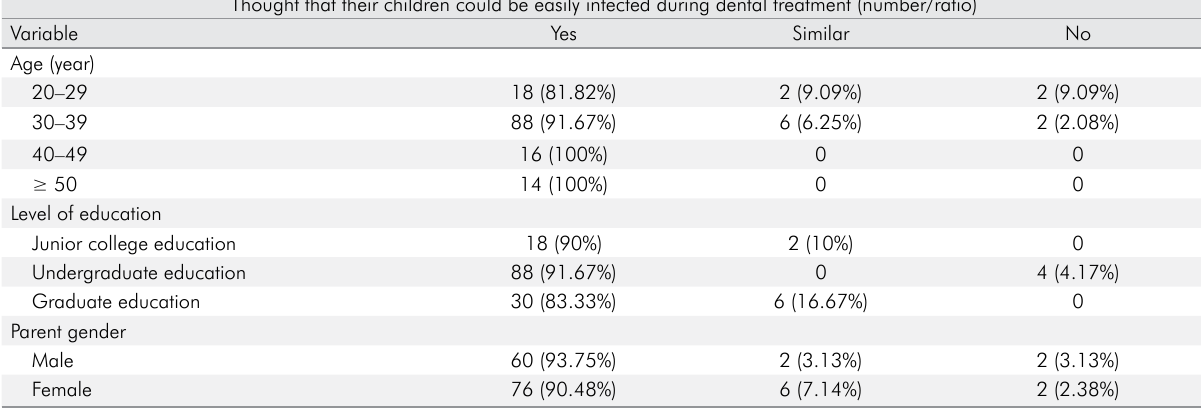
Table 4. Data on parents’ beliefs that their children could be easily infected during dental treatment (by parent age, level of education and gender).